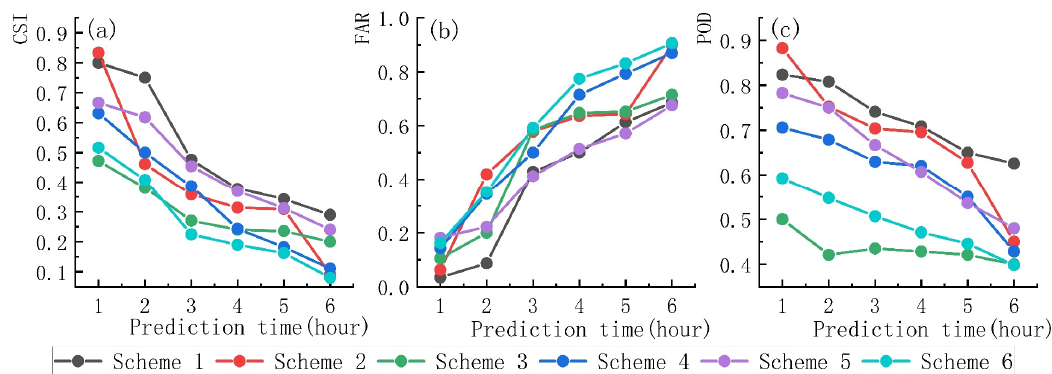
Figure 5. ( a ) CSI , ( b ) FAR , ( c ) POD of hourly rainfall forecast in Suyukou station when k =10 .